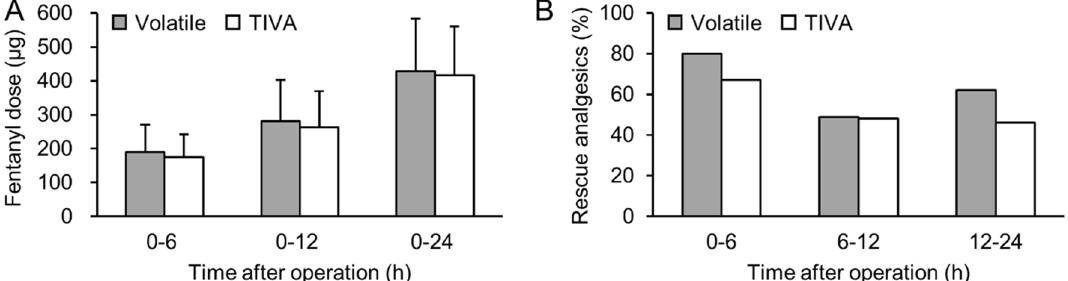
Figure 5. ( A ) Cumulative fentanyl dose administered via intravenous patient-controlled analgesia, and ( B ) use of rescue analgesics during the first 24 h after operation. TIVA, total intravenous anesthesia. Values are expressed as mean ± SD or